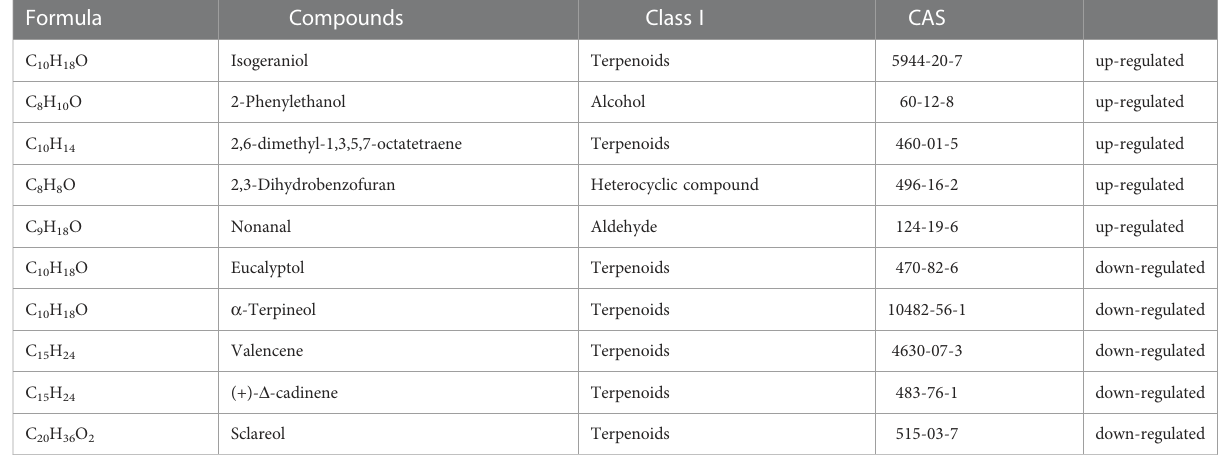
TABLE 2 Five signi fi cantly up-regulated and fi ve down-regulated substances in terpenoid biosynthesis.